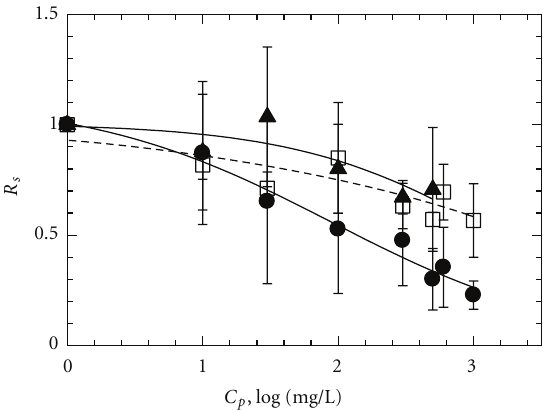
Figure 1: Normalized specific four-day growth ( R s ) dose-response curve. Solid circles are Al 2 O 3 (17.6nm). Open squares are SiO 2 (14.3nm). Solid triangles are TiO 2 (18.7nm). Error bars are ± 1 standard deviation ( n ≥ 3). Lines represent four-parameter logistic curves fitted to the data in SigmaPlot ver. 9.01. Experimental conditions: initial algae concentration = 1 . 4 ± 0 . 9 × 10 6 cell/mL, test duration = 4 days, and initial test volume =